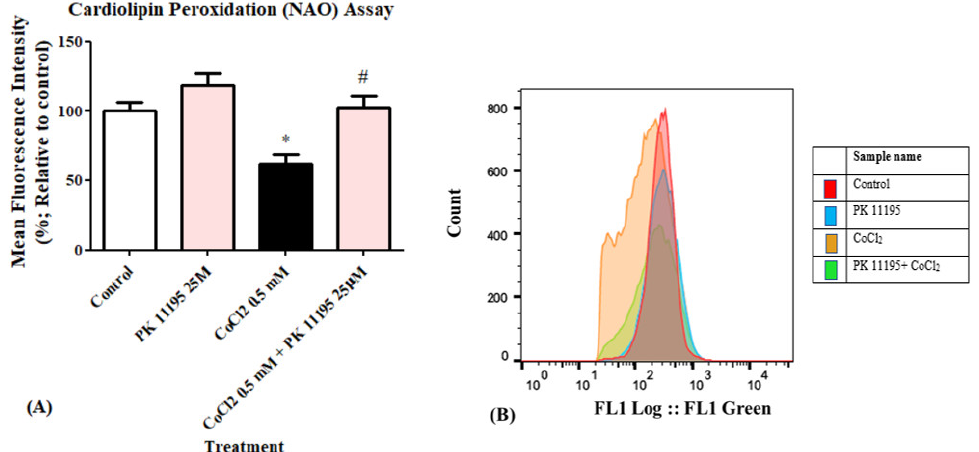
Figure 3. Determination of the efficacy of 25 µM PK 11195 to counteract the effect of 0.5 mM CoCl 2 - induced cardiolipin peroxidation in H1299 cells. The protective efficacy of PK 11195 is shown as ( A ) a bar graph; ( B ) Representative of histogram of the control and CoCl 2 groups, results are expressed by mean ± SD ( n = 5 replicates in each group), and ( B ) a histogram. * p < 0.05 compared to control and # p < 0.05 compared to CoCl 2 .